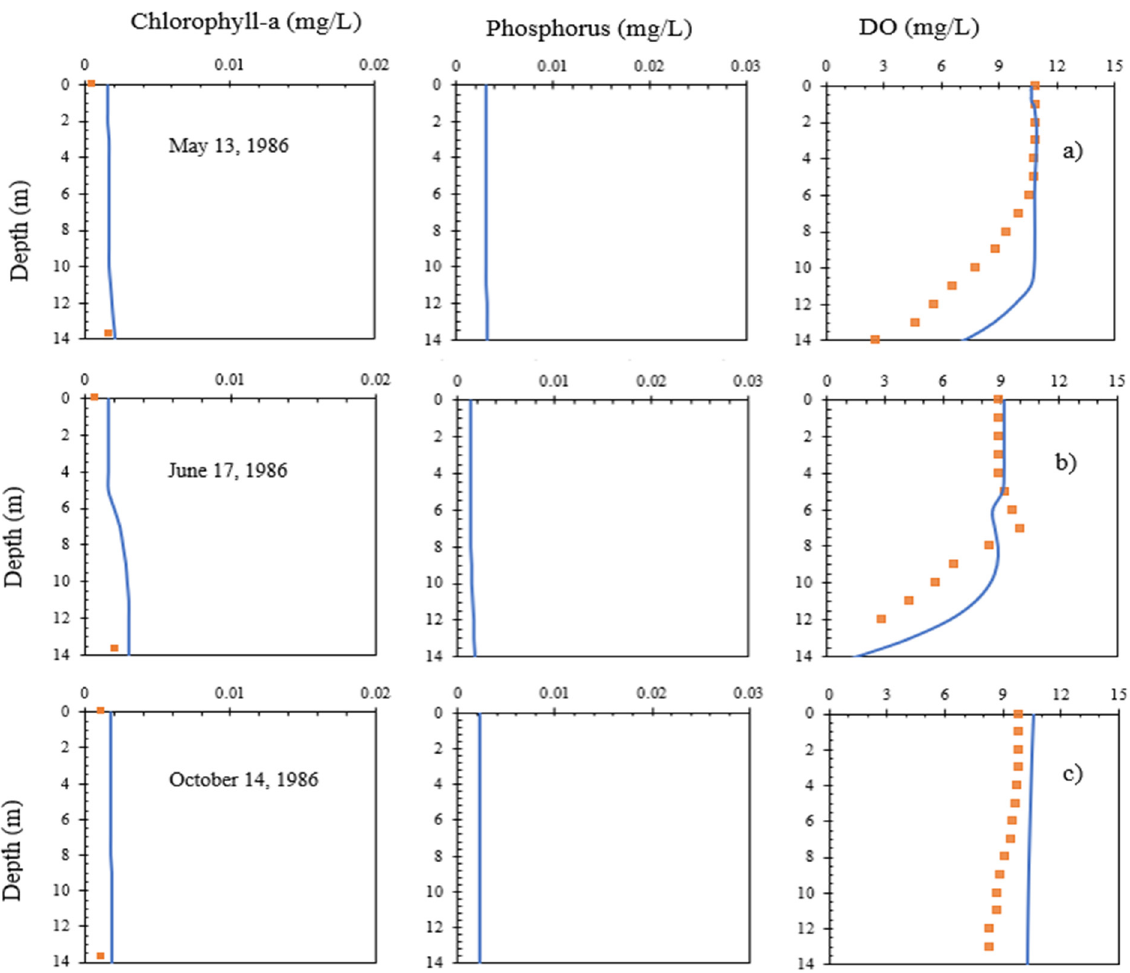
Figure 12. Simulated ( line ) and observed ( dots ) chlorophyll-a, phosphorus, and dissolved oxygen profiles for Thrush Lake on ( a ) 13 May, ( b ) 17 June, and ( c ) 14 October 1986.